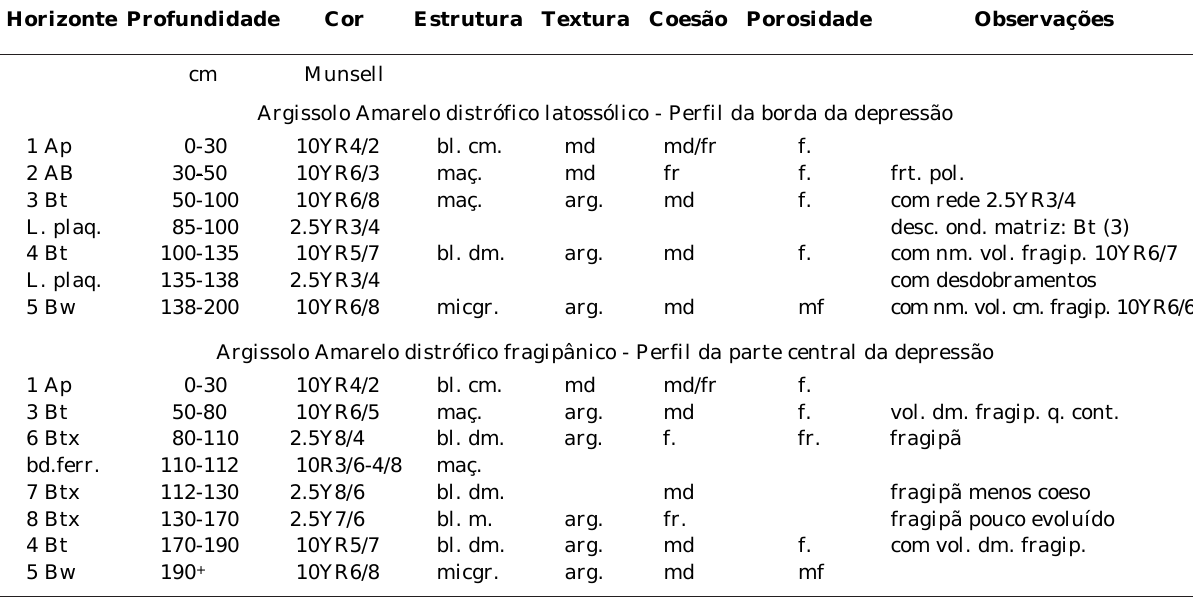
Os números da primeira coluna referem-se aos horizontes da Figura 2a. l. plaq.: linha de plaquetas ferruginosas; bd. ferr.: banda ferruginosa. Estrutura: bl.cm.: blocos centimétricos; maç.: maciça; bl. dm.: blocos decimétricos; micgr.: microagregado. Textura: md: média; arg.: argilosa. Coesão: fr: fraca; md: média; f.: forte. Porosidade: mf: muito forte; f.: forte; fr.: fraca. Observações: frt. pol.: fratura poliédrica; c/: com; desc.: descontínua; ond.: ondulada; nm.: numerosos; vol. cm. fragip.: volumes centimétricos de fragipã; vol. dm. fragip.: volumes decimétricos de fragipã; vol. fragip. q. cont.: volumes de fragipã quase